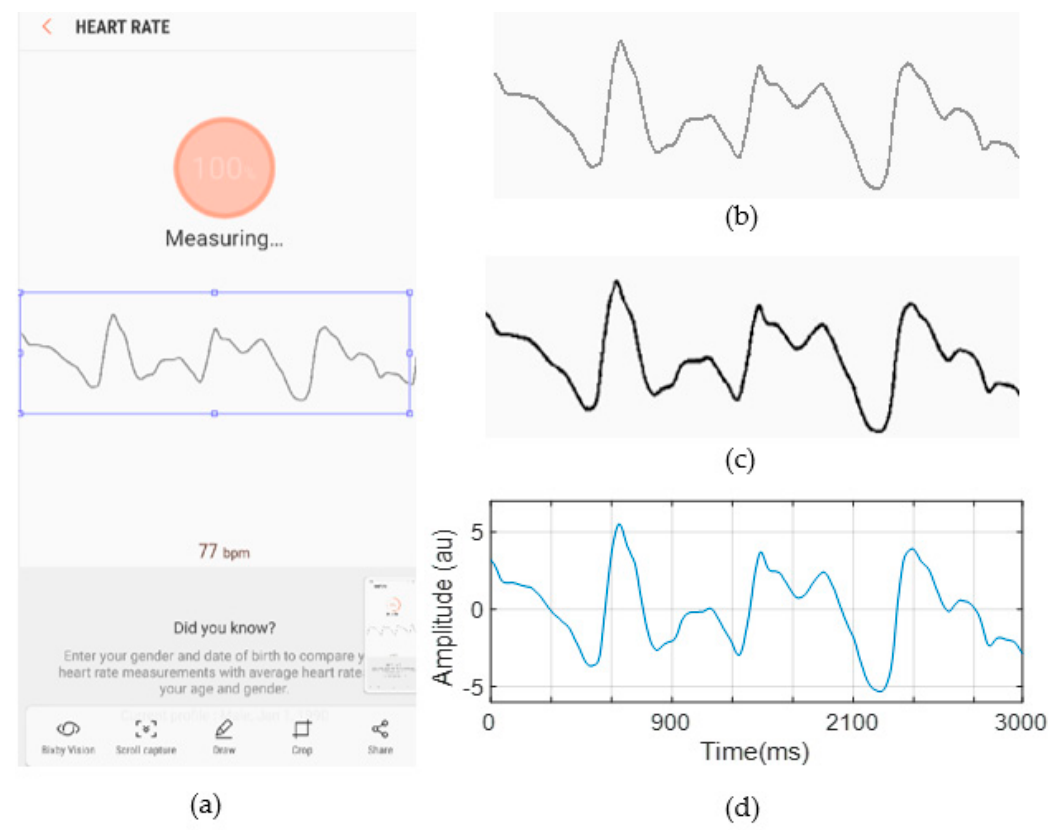
Figure 4. An example of output result at each step of our proposed data processing procedure. ( a ) Screenshot from the smartphone built-in application, ( b ) its cropped image, ( c ) the binary image derived by the RGB to HSV transformation and background removal, and ( d ) extracted signal by scaling the binary image to the x-y axis.